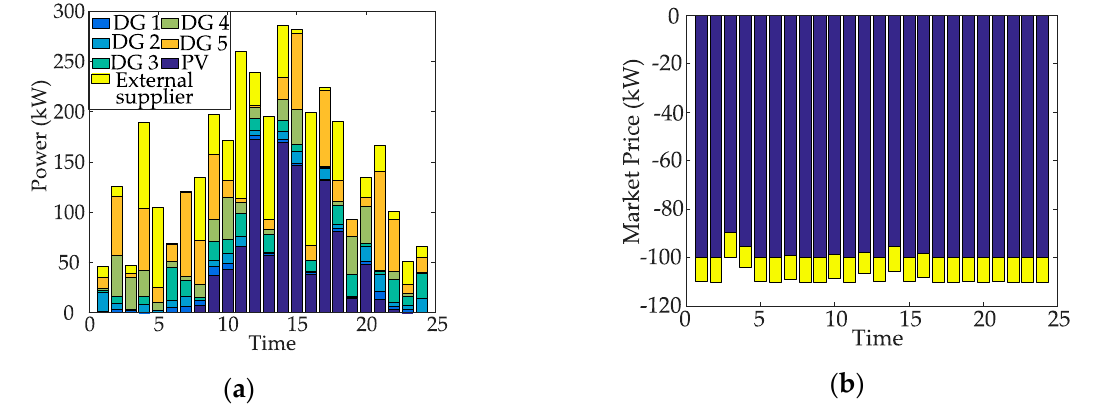
Figure 3. Scheduling: ( a ) Distributed generation; ( b ) Sale of power in the market.